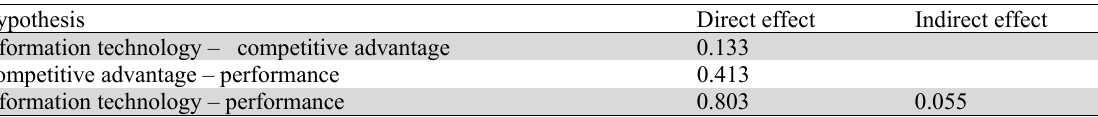
Direct and indirect effects Hypothesis Direct effect Information technology – competitive advantage